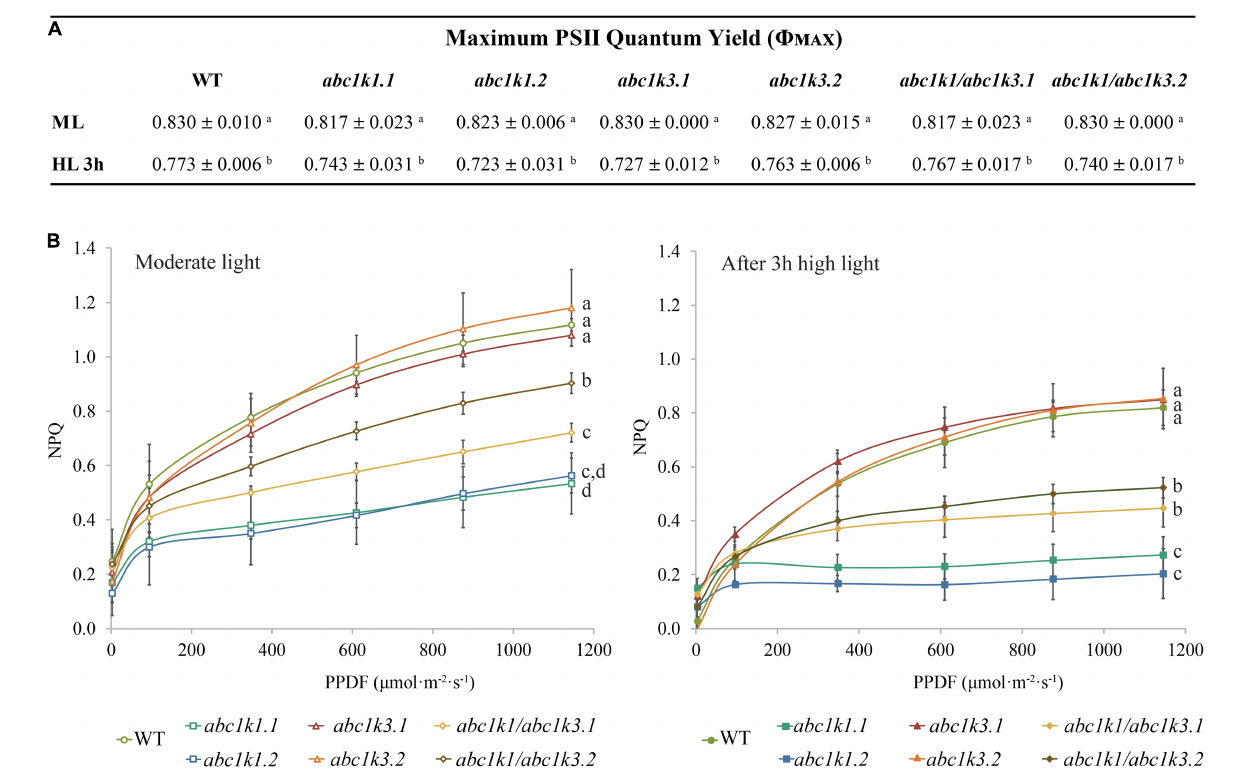
FIGURE 2 | Non-photochemical quenching is partially recovered in abc1k1/abc1k3 lines compared to abc1k1 . (A) PSII maximum quantum efficiency ( (cid:56) PSII = (F M – F O )/F M ) and (B) non-photochemical quenching (NPQ) of 4–5 weeks old plants of wild type (WT), abc1k1.1, -2, abc1k3.1, -2 and abc1k1/abc1k3.1, -2 under moderate light and after 3 h of high light. Plants were dark-adapted 10 min before measurement. Non-photochemical quenching (NPQ = (F M – F M ’)/F M ’) was calculated from the maximal fluorescence at room temperature recorded after 1 min of exposure at increasing blue light intensities (470 nm). These measures were performed with a Fluorcam (MF800 – PSI). Each value represents the average of a pot containing 2–3 plants. Superscript letters are used to indicate statistically different groups ( p < 0.05) by paired Student’s t -test. Error bars indicate ± SD between different pots ( n =